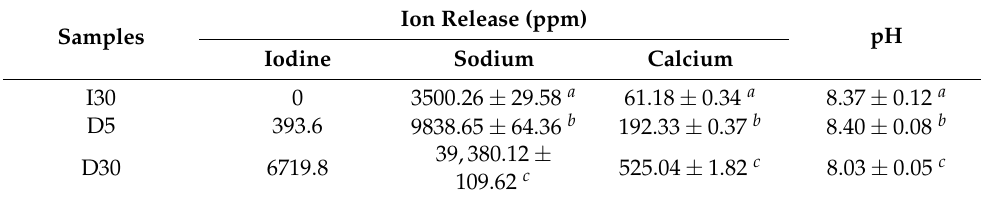
Table 3. Iodine, sodium, and calcium ion releases and pH of the samples (mean ± SD).